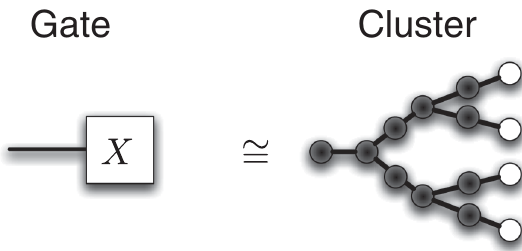
FIG. 9. An adiabatic measurement amplifier. A binary tree with alternating degree 2 and 3 internal vertices (as shown) can be used to take information encoded into the (cid:1) X eigenstates at the root into a code across the leaves by turning on an X field across the shaded qubits. This code has a stabilizer given by Z terms on leaves; i.e., it is the repetition code. The logical information initially at the root in the X eigenstate is in this process copied into the Z eigenstates of the leaves. Thus, if one P Z interaction, the information initially in the X turns on a i i eigenstate will be separated in energy by twice the number of leaves. The natural relaxation of this system to its ground state will result in O ð #leaves Þ relaxation events, which can be indi- vidually (noisily) observed, hence amplifying a measurement in the X eigenvector